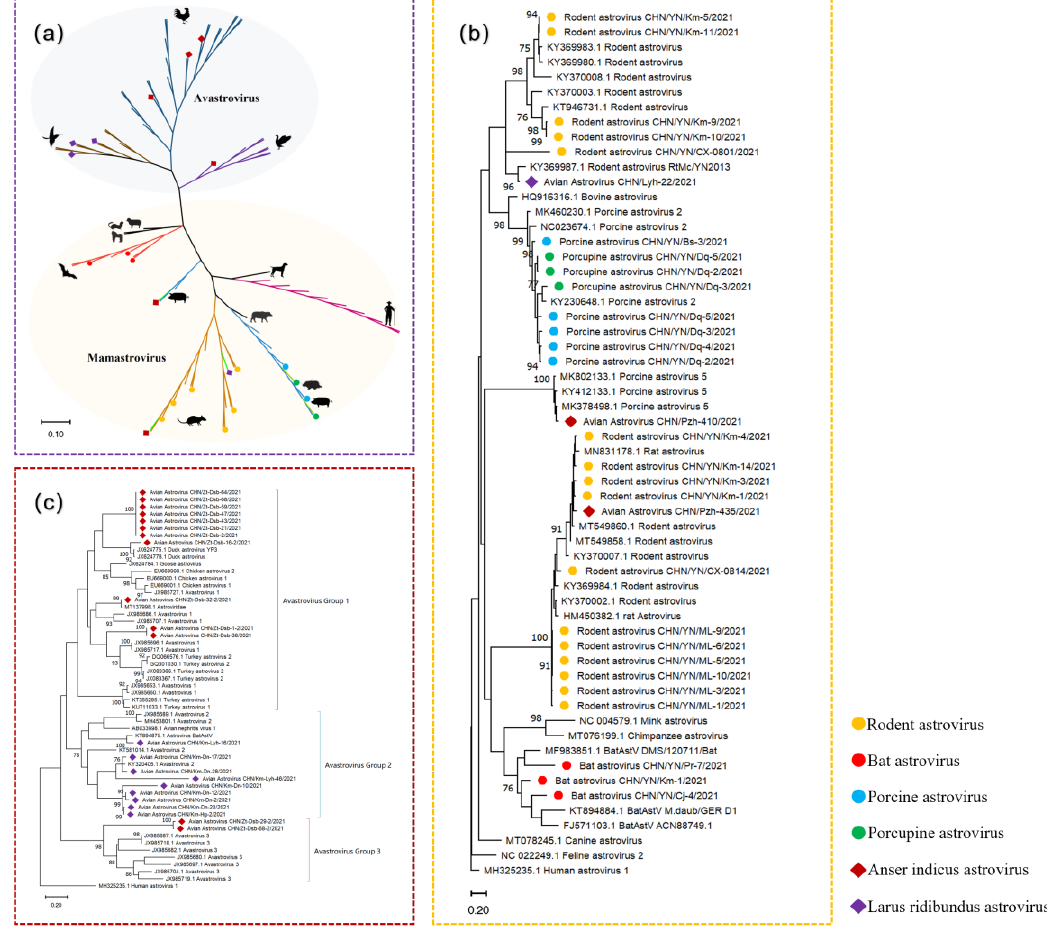
Figure 1. ( a ) According to the partial nucleotide sequences of the RdRp gene (369 bp), sequence comparison and clustering were performed with representative AstVs. Maximum likelihood method was used to construct tree (ML), model (GTR + G + I), and bootstrap analysis was performed 1000 times; ( b ) phylogenetic tree based on partial nucleotide sequences of RdRp genes (369 bp) of MAstV, model (GTR + G + I); ( c ) phylogenetic tree based on partial nucleotide sequences of RdRp genes (369 bp) of AAstV, model (GTR + G + I). The strains obtained in this study are represented by different color symbols.